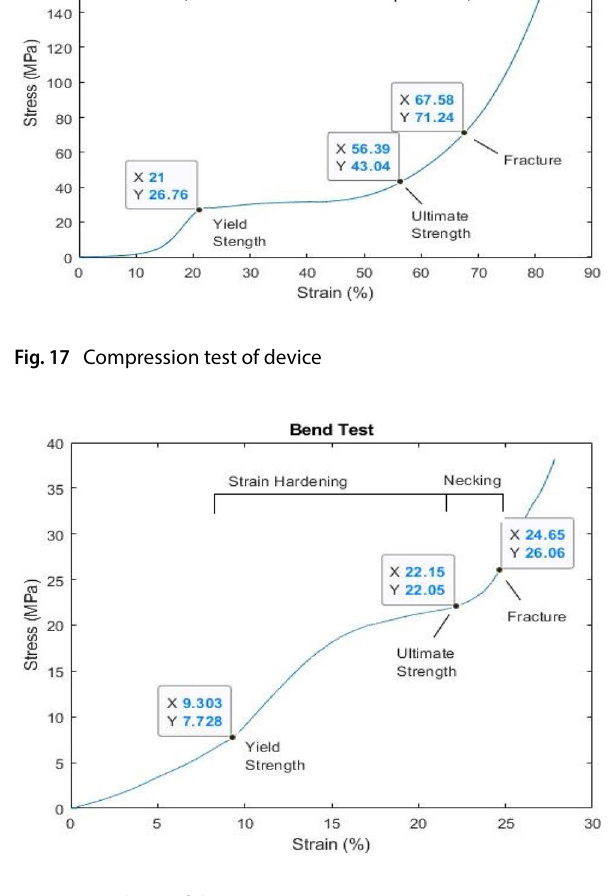
Fig. 18 Bend test of